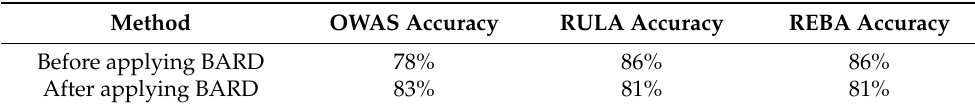
Table 7. Evaluation and comparison of accuracy of occluded posture for validation datasets.